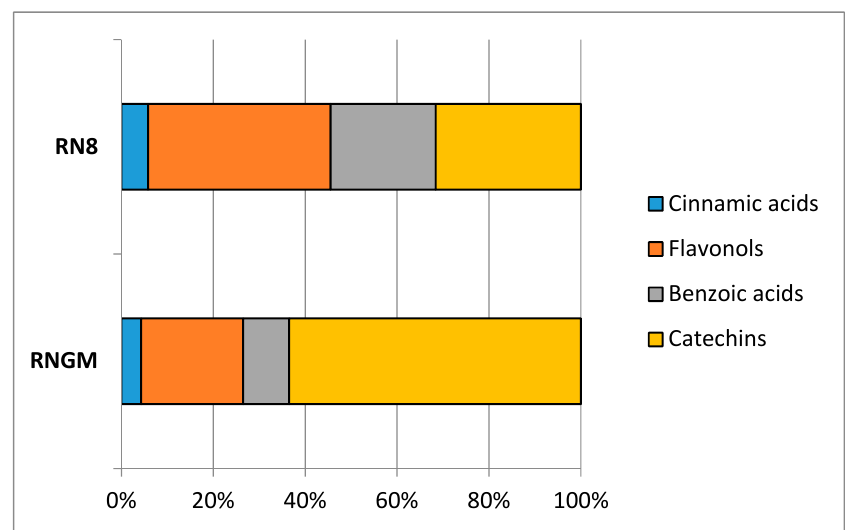
Figure 4. Contribution of each polyphenolic class to the total phytocomplex in RN8 and RNGM analyzed samples.